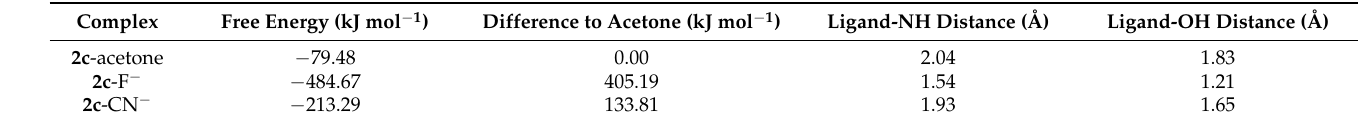
Table 2. Calculated free energy and interatomic